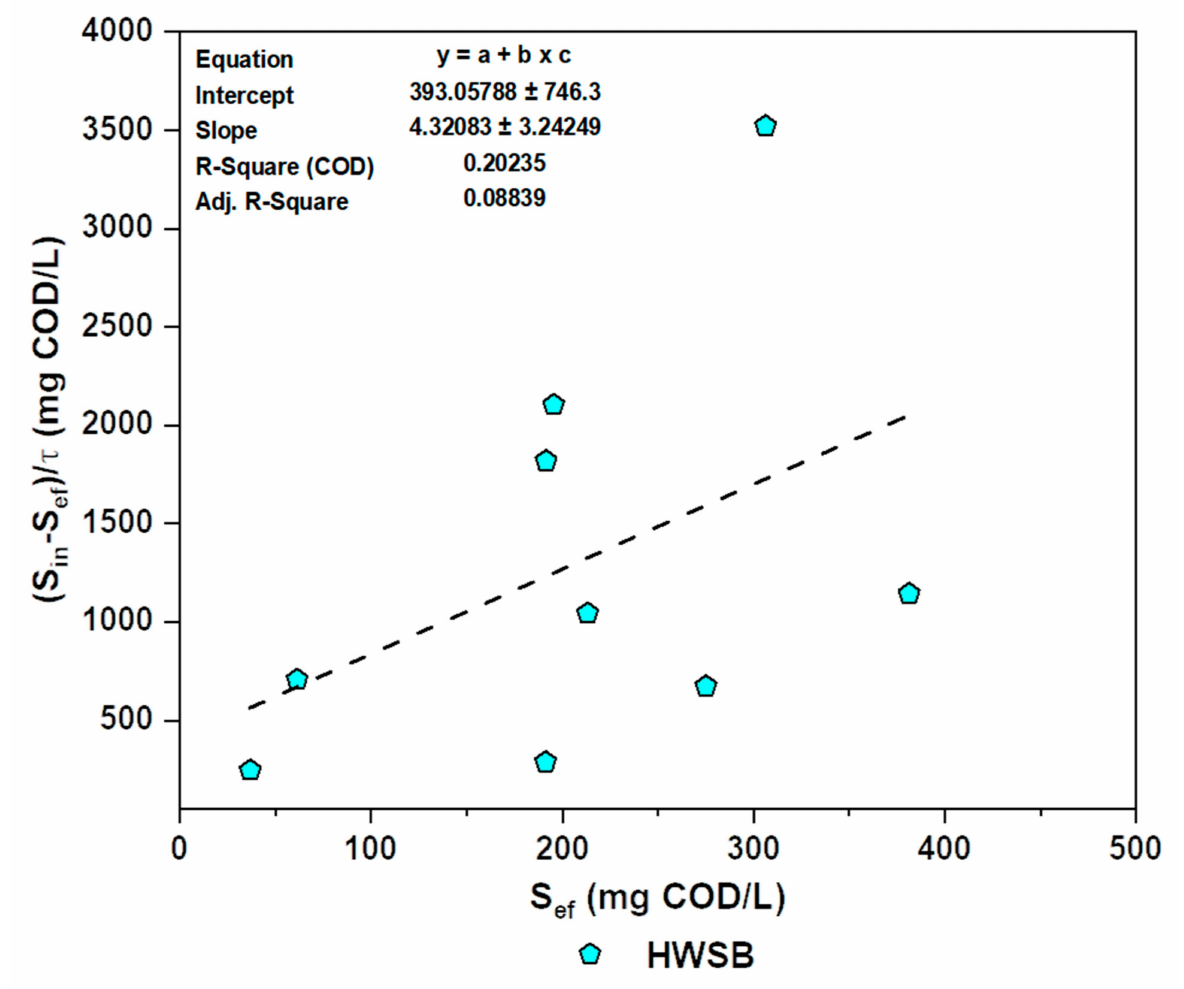
Figure 9. First-order kinetic plot of COD for